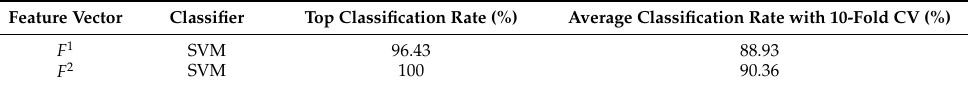
Table 1. Comparison of feature vector